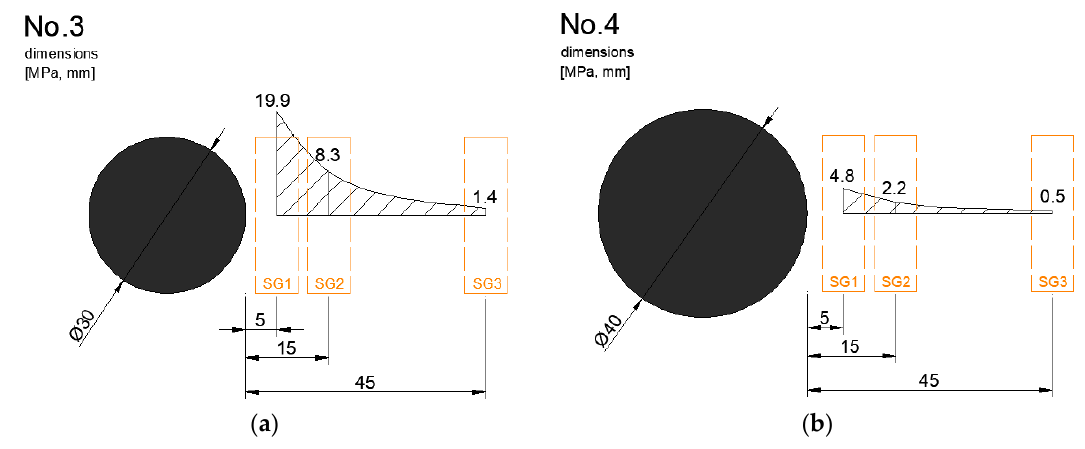
Figure 10. Stress results on testing beams (force 10 kN): ( a ) No.3—dowel Ø 30 mm; ( b ) No.4—dowel Ø 40 mm.